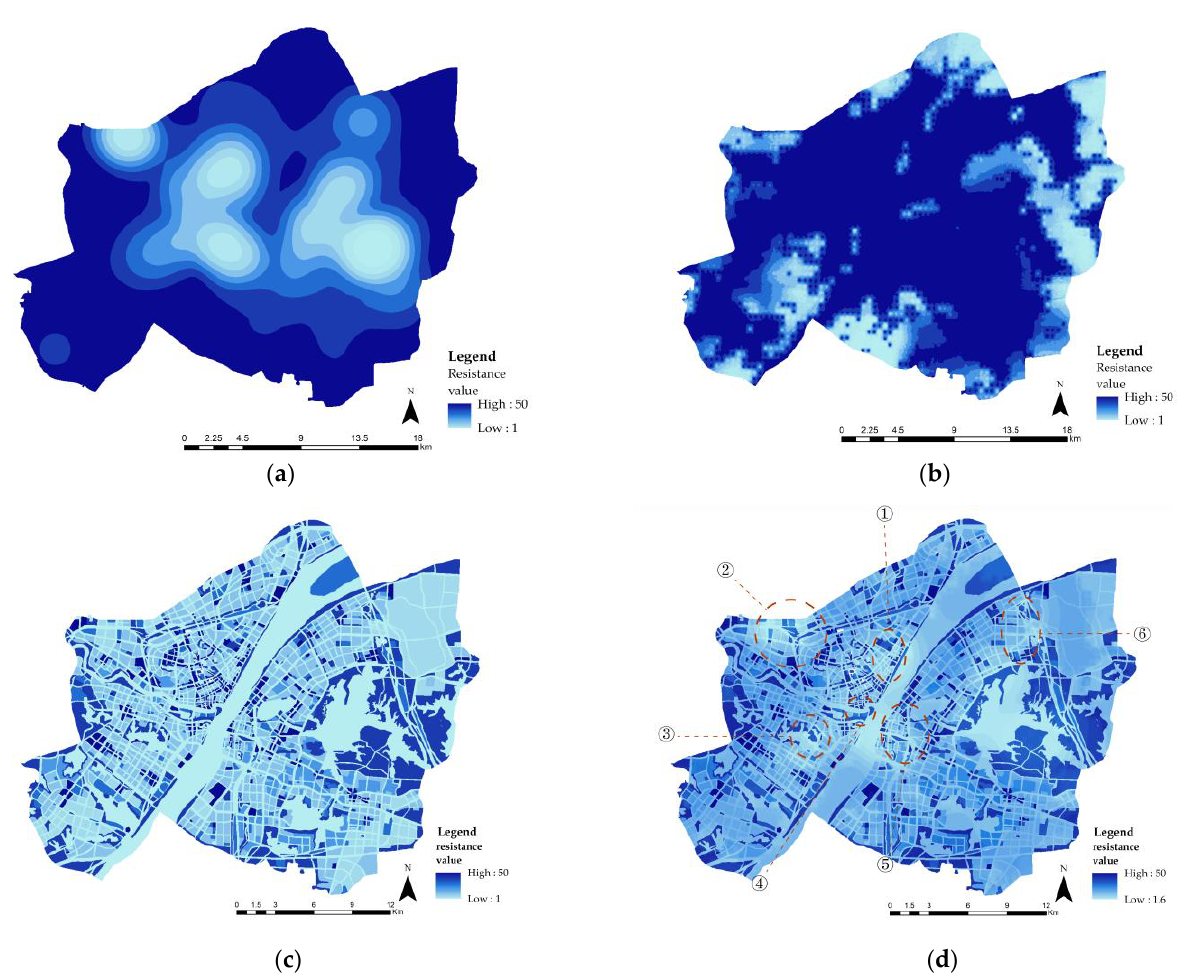
Figure 8. Resistance distribution: ( a ) leisure and Recreational resistance distribution, ( b ) Water conservation resistance distribution, ( c ) Runoff resistance distribution and ( d ) Comprehensive resistance distribution.